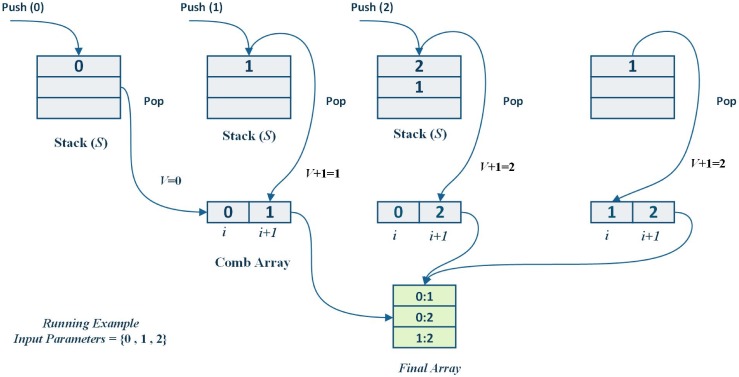
A Running Example.